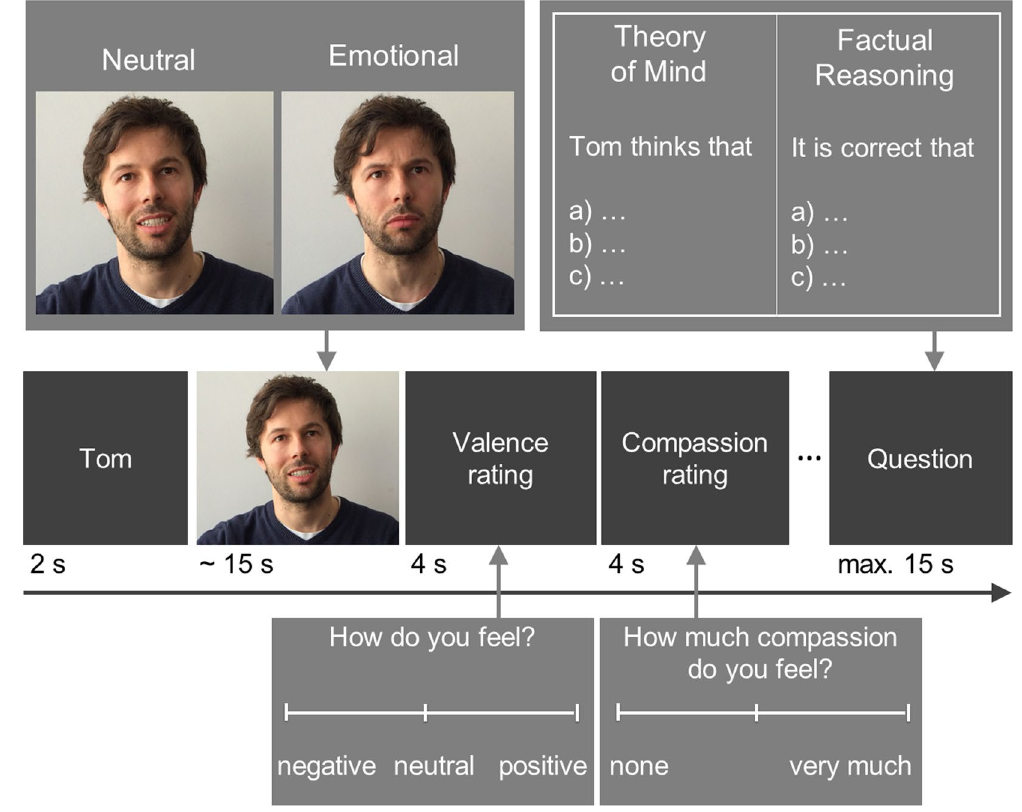
Figure 1. Schematic of the EmpaToM trial sequence and task overview (adapted from Kanske et al . 20 ).